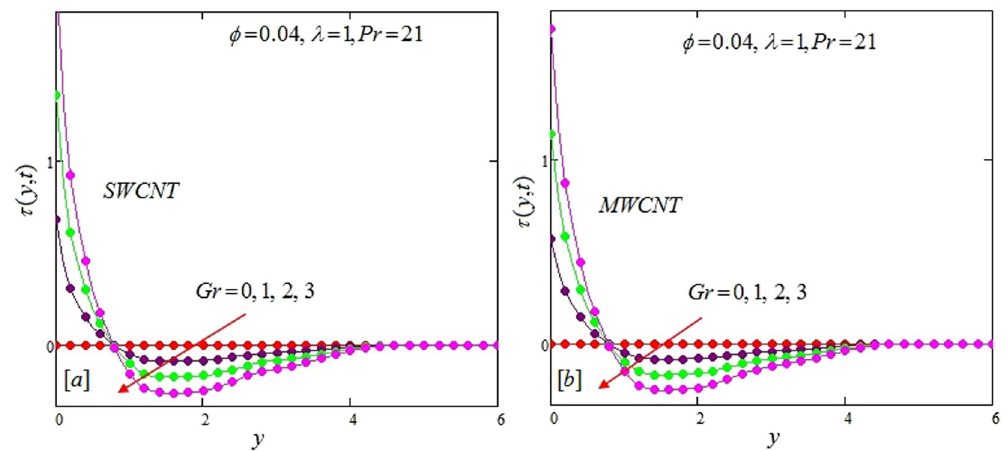
Figure 8. Shear stress profiles for single and multiple wall CNTs for different values of Grashoff